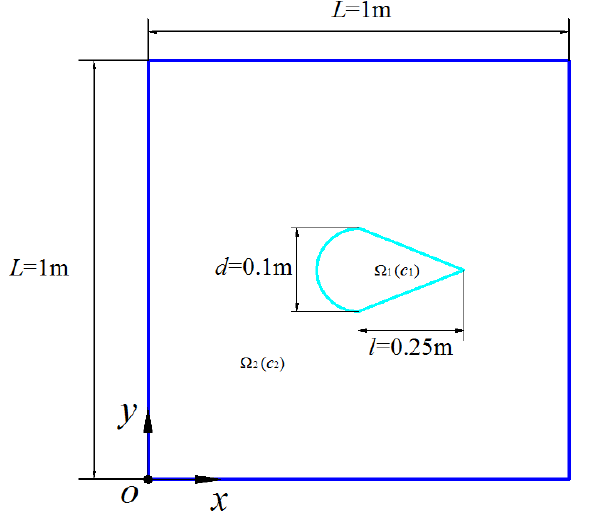
Figure 19. The geometry parameters of the two-dimensional acoustic wave scattering problem by irregular objects.